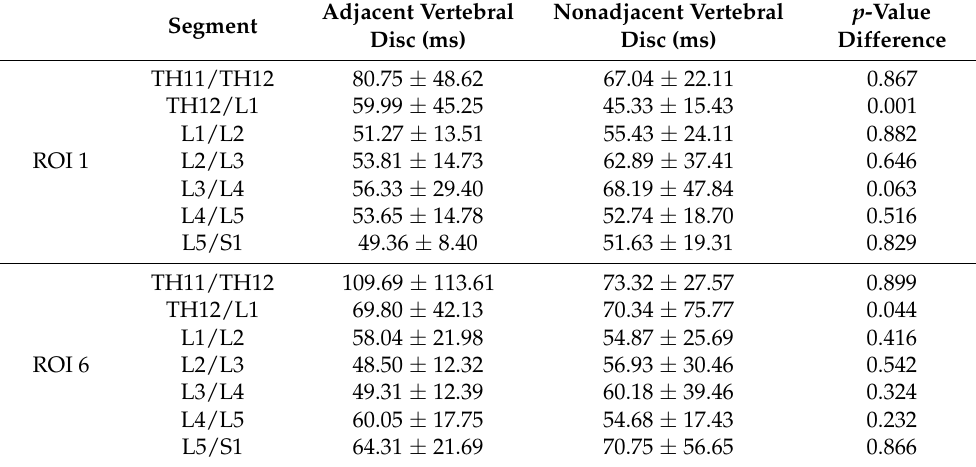
Table 2. Outer part (OP) of the intervertebral disc. Mean T2 relaxation time values ± standard deviation (SD) for adjacent and nonadjacent IVDs of the outer part (OP) represented by ROI 1 and ROI